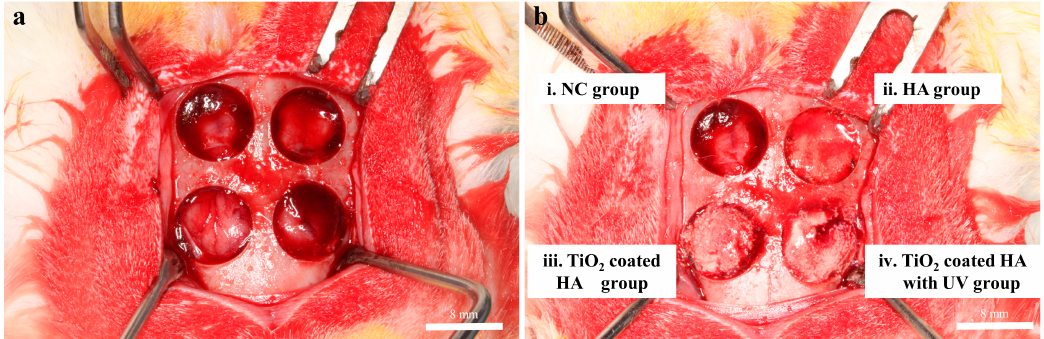
Figure 6. Clinical photographs of the experiment. ( a ) Photograph of four transosseous defects 8 mm in diameter, >2 mm apart, that were created using a trephine bur in the each calvaria of 12 rabbits. ( b ) Defects were filled with the following graft materials. i. Unfilled as a negative control, NC group; ii. 0.025 g of HA, HA group; iii. 0.025 g of TiO 2 -coated HA, TiO 2 -coated HA group; and iv. 0.025 g of TiO 2 -coated HA with UV treatment for 1 min, TiO 2 -coated HA with UV group.